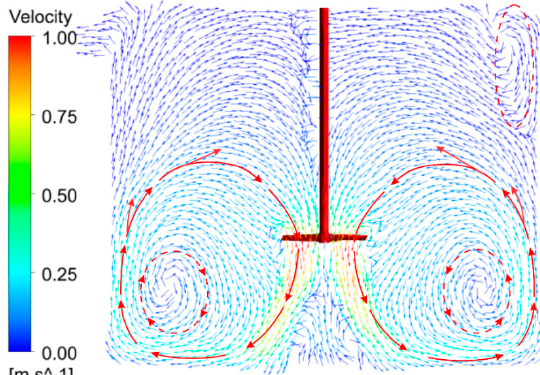
Figure 4. Velocity vector plot in a vertical plane.